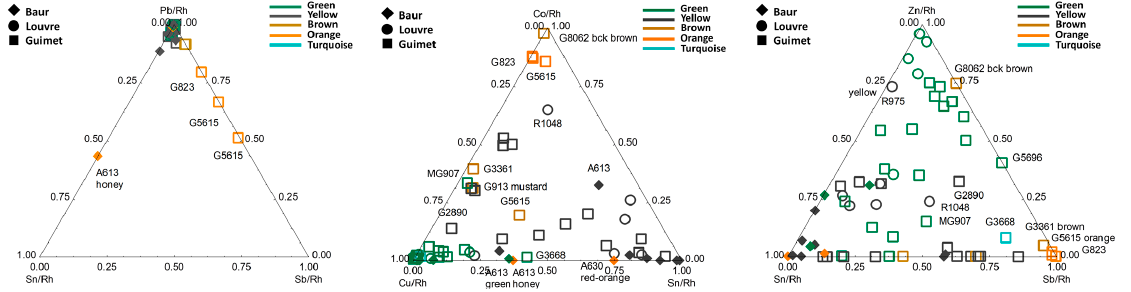
Figure 11. Comparison of the signal of elements associated with the yellow, green/turquoise, and brown/orange colored areas (normalized with Rh signal).